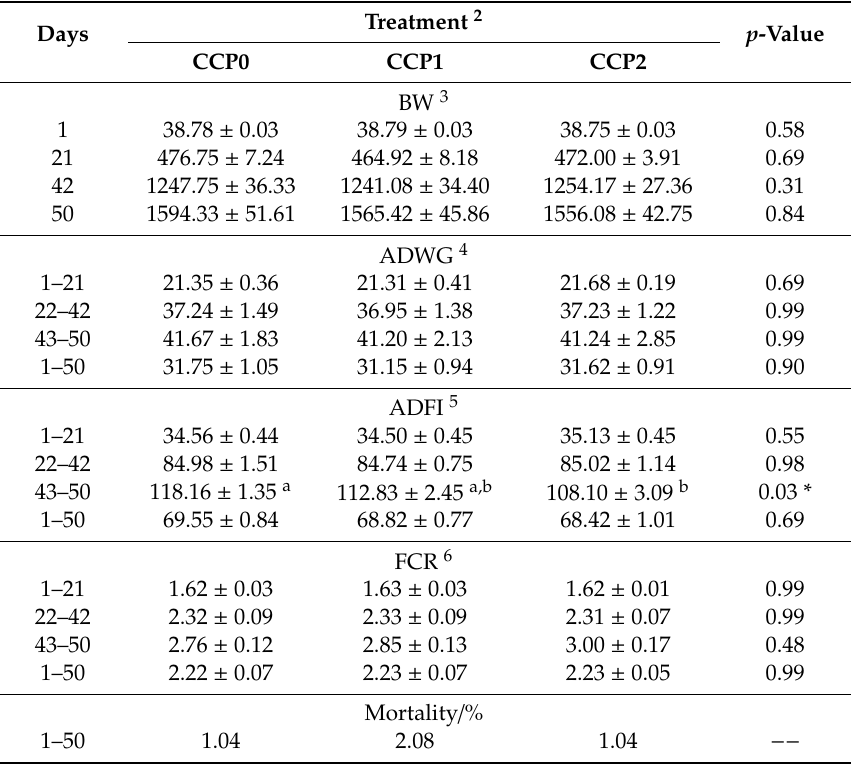
Table 3. Growth performance ( ± SEM 1 ) of yellow broilers fed diets containing di ff erent contents of Camellia oleifera cake polysaccharides from 1 to 50 days of